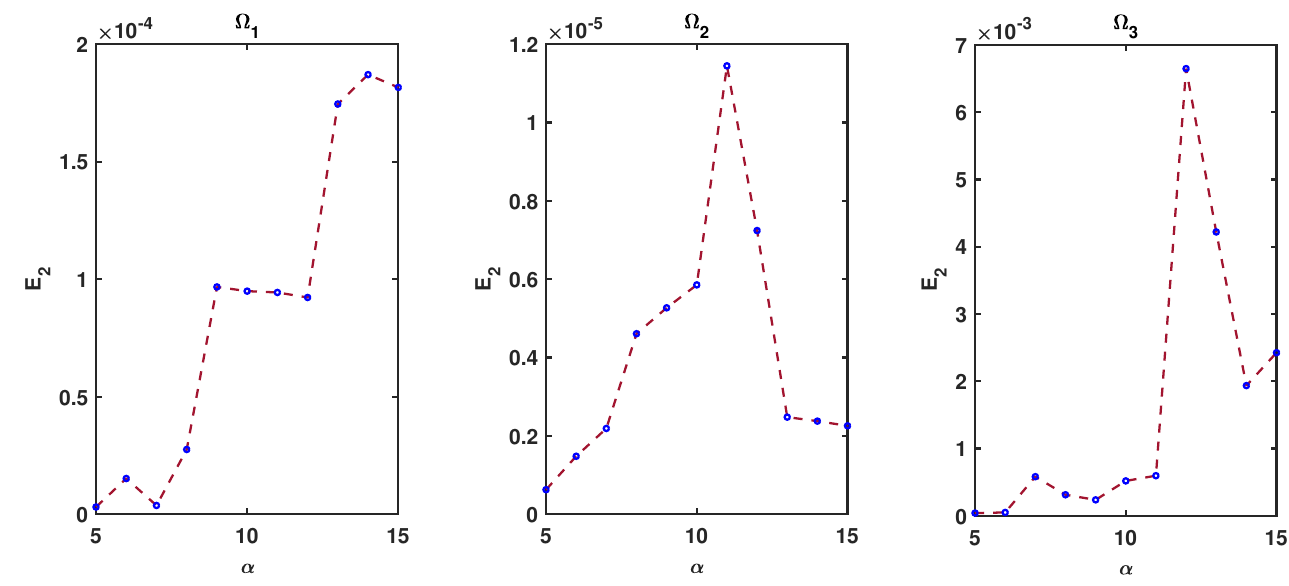
Figure 7. E 2 errors in different α at T = 0.5 and τ = 0.04, c = 5, ν = 2, γ = 0.5, K = 140, K 1 = 90, M = 209, and N = 101 for Example 2.